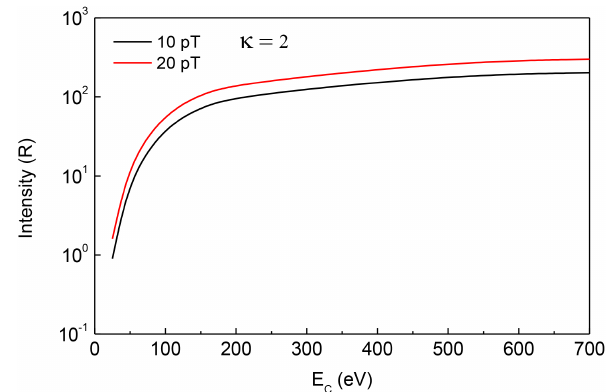
Figure 7. Intensity of OI1356Åemission in Rayleigh ( R ) ver- sus characteristic energy ( E c ) for a kappa distribution with κ = 2. Whistler wave amplitude is indicated.